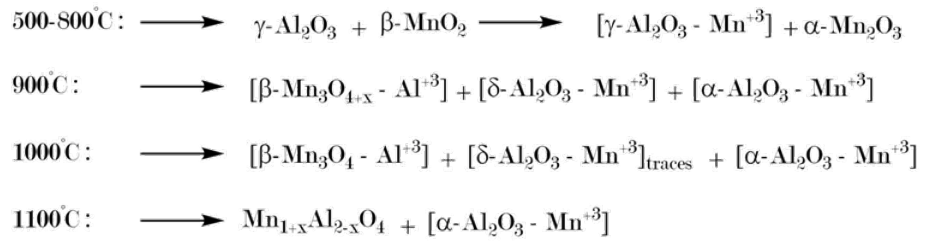
Figure 11. SEM images of anodized aluminum oxide (AAO) membranes having undergone different treatment: ( A ) AAO-0 pristine, ( B ) AAO-1100 after calcination at 1100 °C, and ( C ) AAO-900-Mn calcined at 900 °C after impregnation with a manganiferous solution [168].